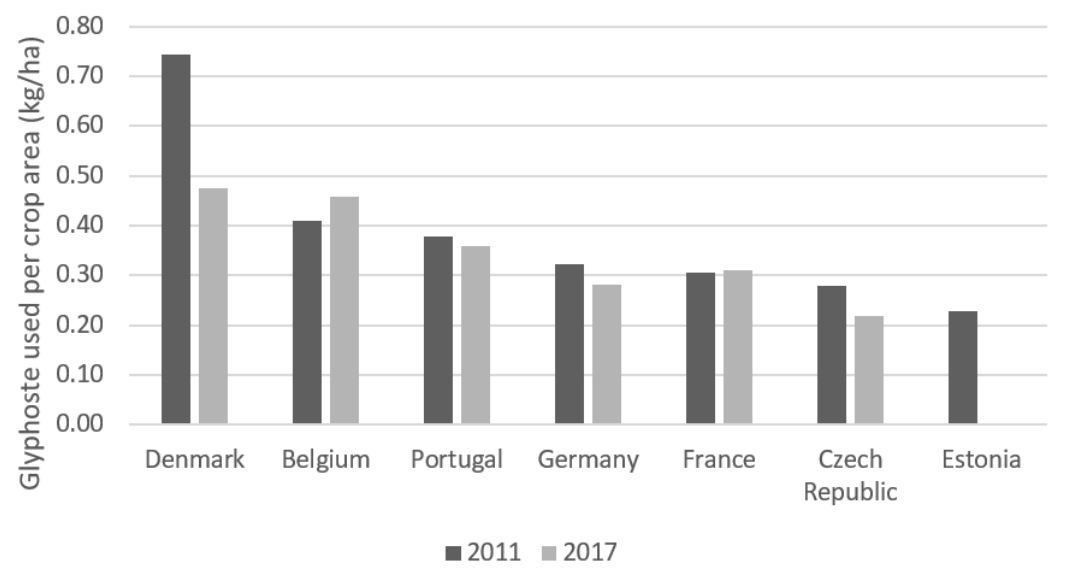
Figure 6. Evolution of glyphosate use (kg/ha) in some European countries, between 2011 and 2017.